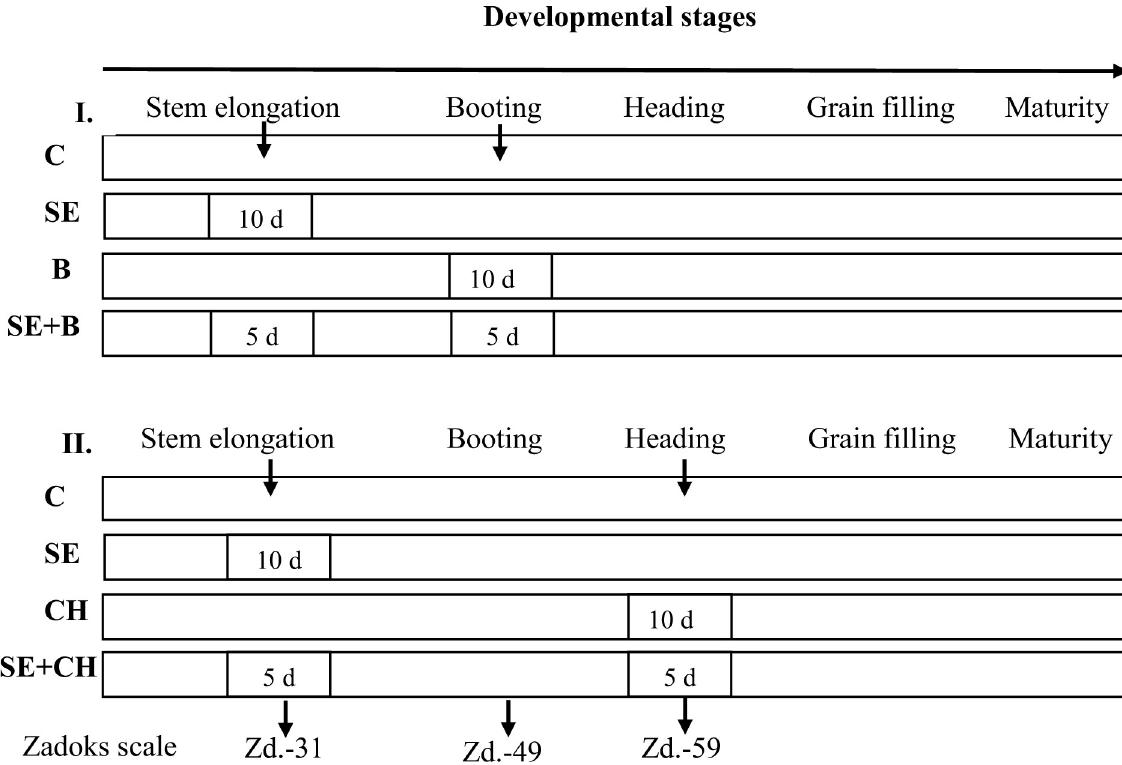
PLOS ONE | https://doi.org/10.1371/journal.pone.0252070 May 25,